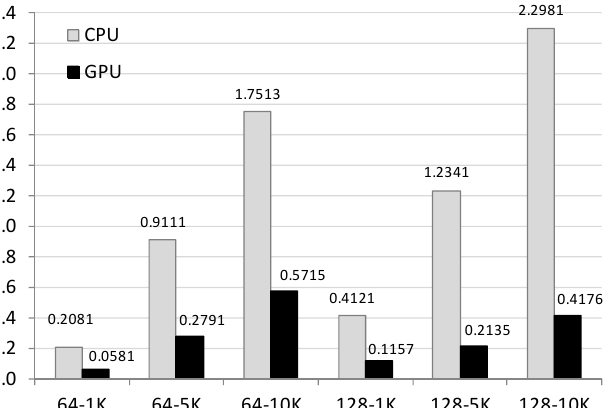
Figure 13. CPU and GPU times (in ms) for Ch130 with respect to different populations (64 and 128) and iterations (1000, 5000, and 10,000).